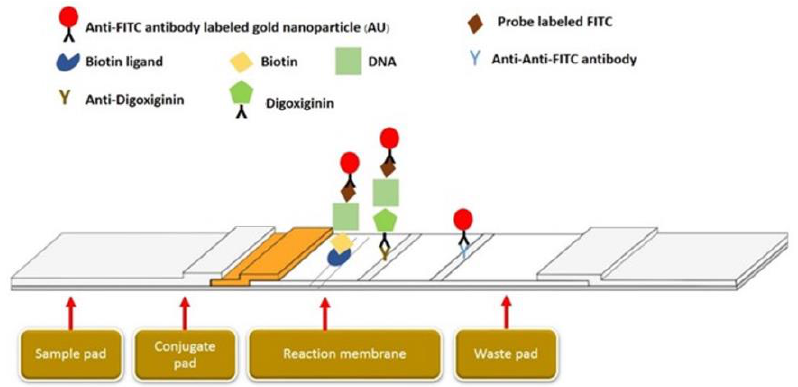
Figure 1. Schematic of LFD assays.